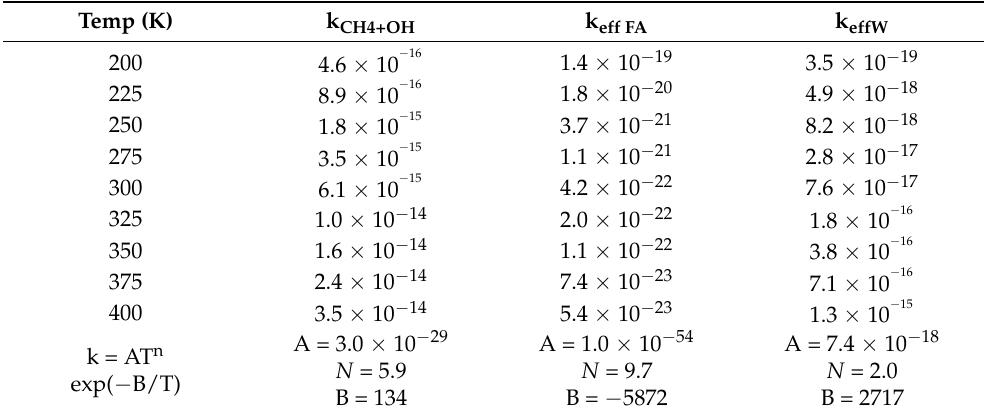
Table 3. Calculated rate constants ( cm 3 molecule − 1 s − 1 ) for the · OH + CH 4 , · OH + CH 4 (+HCOOH) and · OH + CH 4 (+H 2